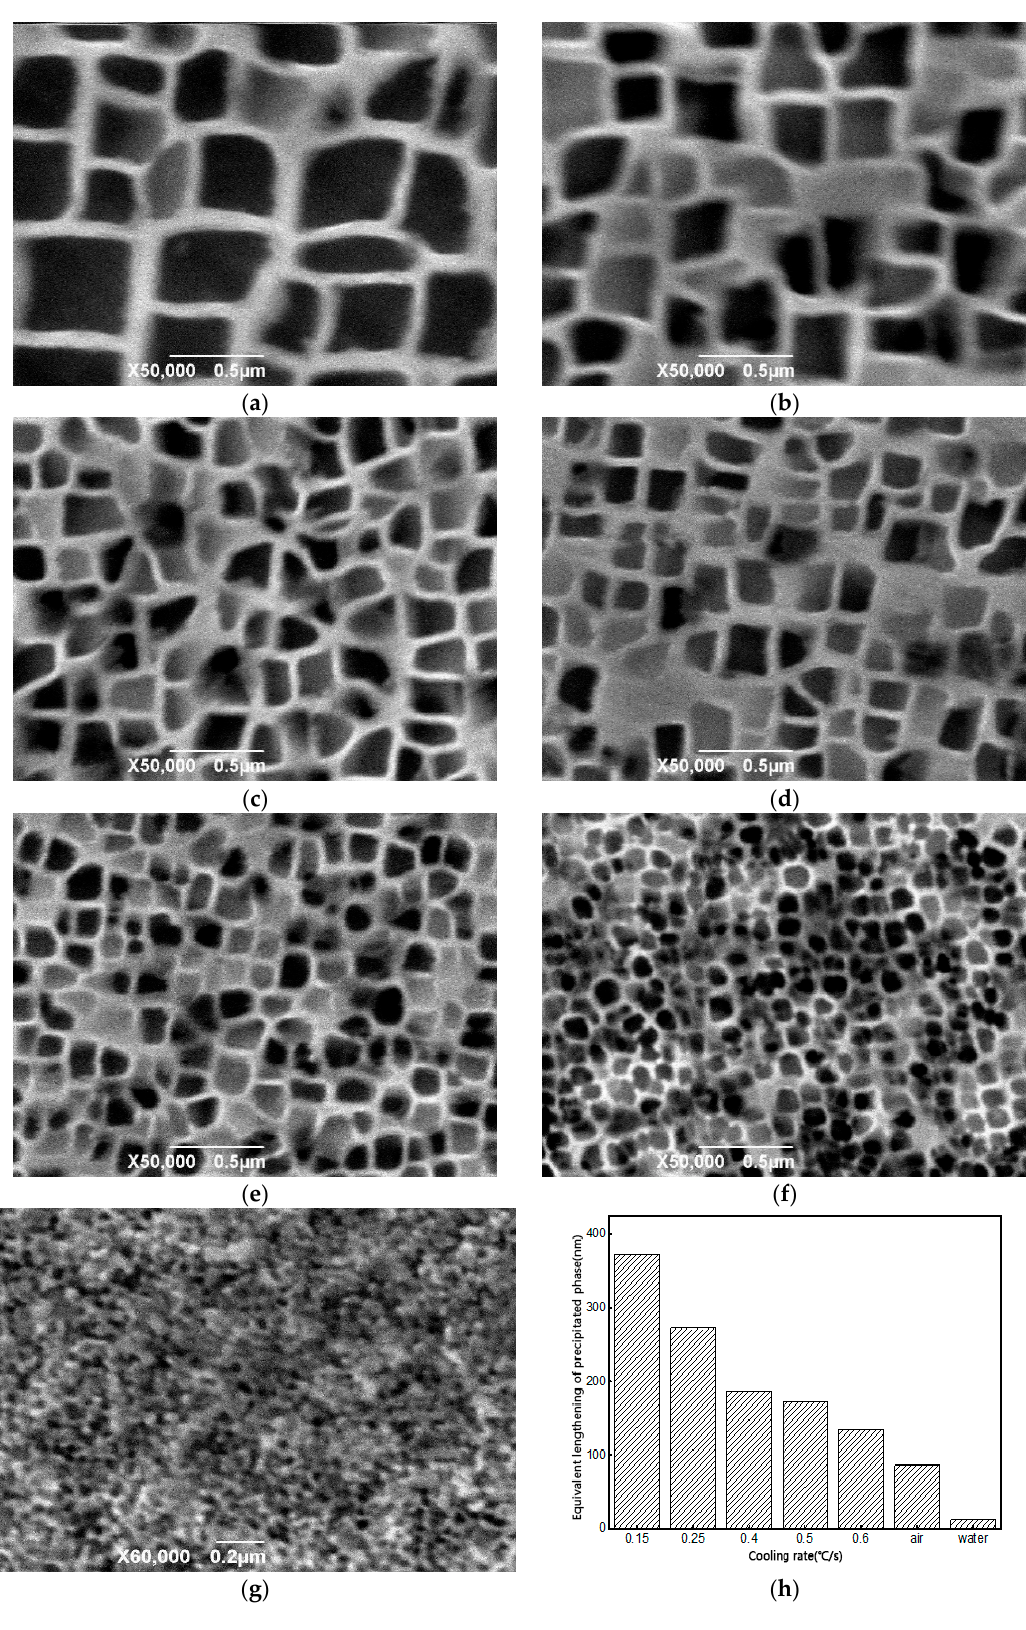
Figure 6. Microstructure of materials obtained by different cooling rates ( a ) 0.15 ◦ C/s; ( b ) 0.25 ◦ C/s; ( c ) 0.4 ◦ C/s; ( d ) 0.5 ◦ C/s; ( e ) 0.6 ◦ C/s; ( f ) Air-cooling; ( g ) Water-cooling; ( h ) Average equivalent side length of the precipitated phase at different cooling